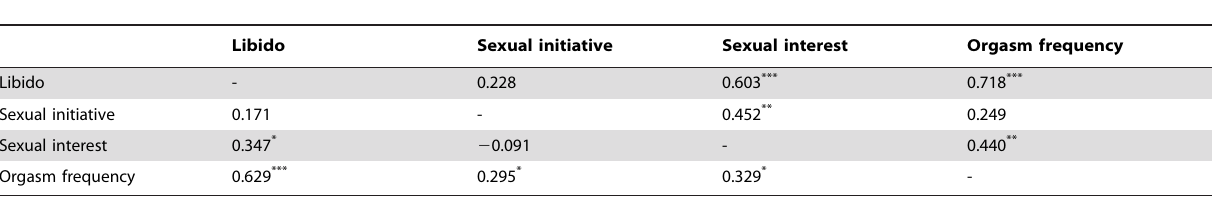
Table 6. Spearman correlations of sexual